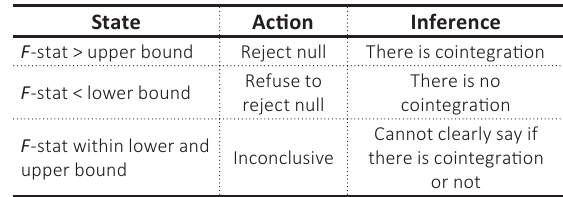
Table 1. Decision rule for bound test